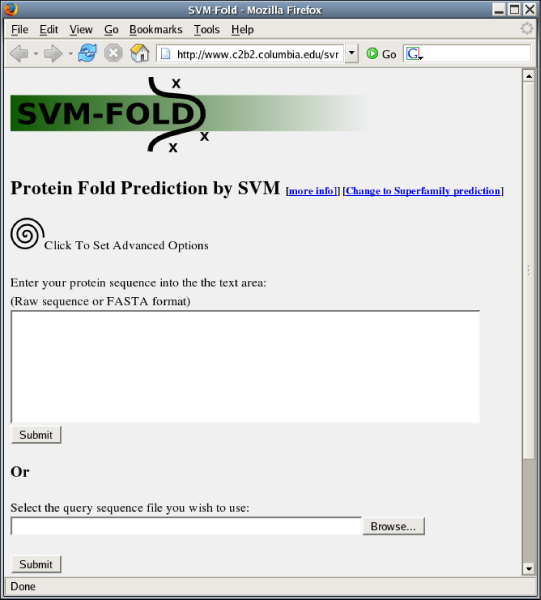
SVM-Fold home page. A screen capture of the